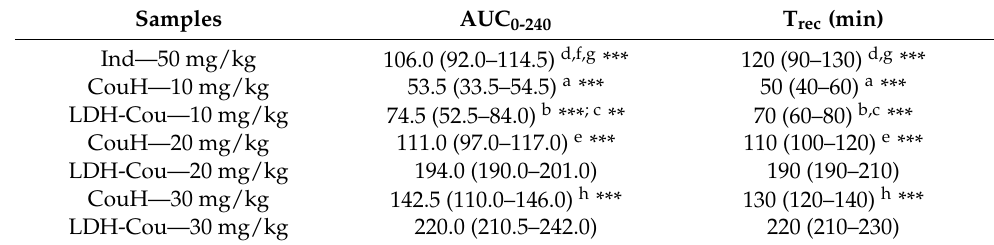
Table 1. Antinociceptive tests. Area under the curve and analgesic time determined in the tail-flick essay. Statistics: a—CouH 10 mg/kg vs. Ind; b—LDH-Cou 10 mg/kg vs. Ind; c—CouH 10 mg/kg vs. LDH-Cou 10 mg/kg; d—LDH-Cou 20 mg/kg vs. Ind; e—CouH 20 mg/kg vs. LDH-Cou 20 mg/kg; f—CouH 30 mg/kg vs. Ind; g—LDH-Cou 30 mg/kg vs. Ind; h—CouH 30 mg/kg vs.